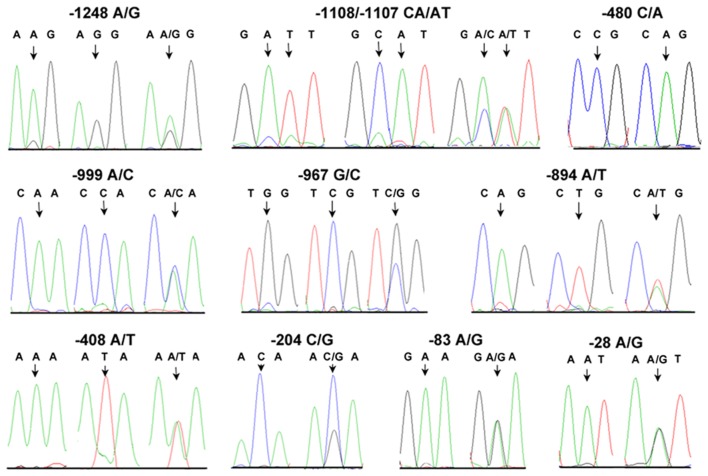
Detection of the genotypes at 11 SNPs in the AiHSP70 promoter region.The unimodal peak indicates the homozygous genotype, and the overlapping peaks indicate the heterozygous genotype.